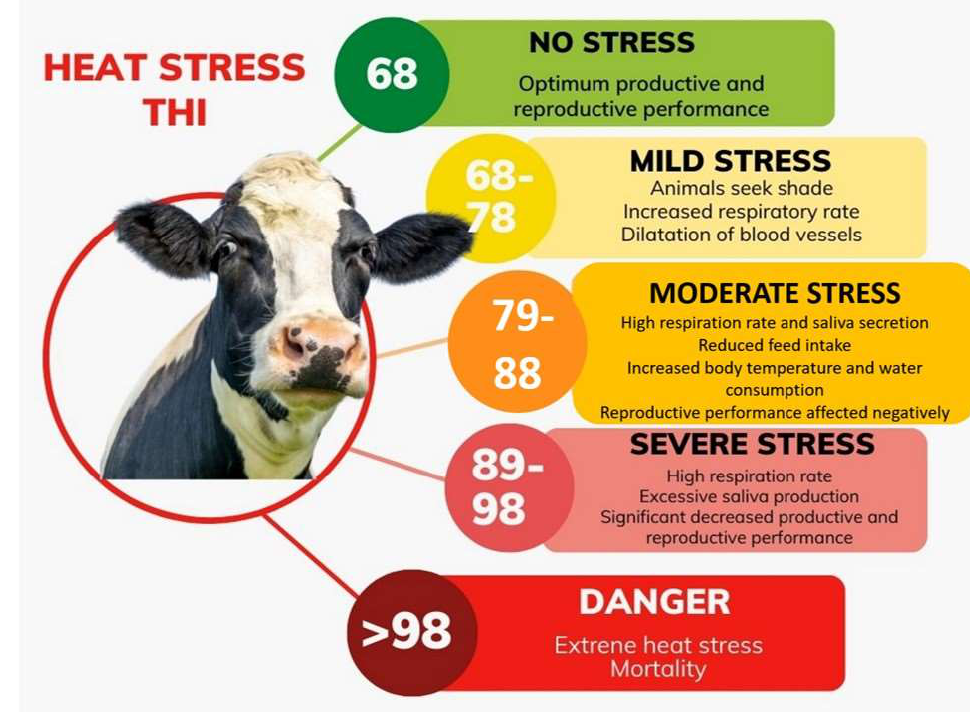
Figure 2. The severity of heat stress in dairy cattle in relation to the THI index.